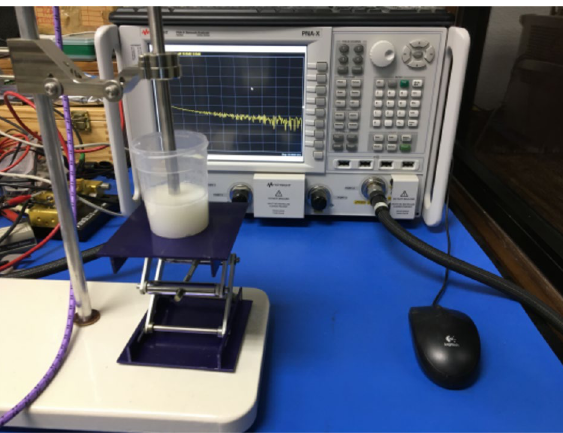
Figure 1. Experimental setup for the characterization of the dielectric properties of each fabricated